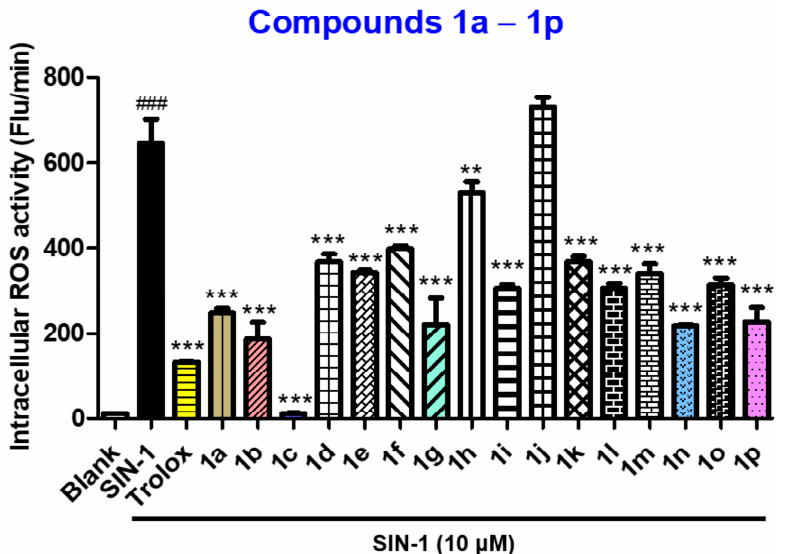
Figure 14. The intracellular ROS scavenging effects of compounds 1a – 1p . Intracellular ROS levels were evaluated using a DCFH-DA assay. The abilities of 1a – 1p to scavenge the oxidative stress induced by SIN-1 (10 µ M) were investigated at 20 µ M using B16F10 cells. Cells were pretreated with the compounds (20 μ M), and then exposed to 10 μ M SIN-1. The symbols * and # indicate significant differences between columns: ### p < 0.001 for cells treated with SIN-1 versus untreated groups; *** p < 0.001 and ** p < 0.01 for SIN-1-treated cells versus SIN-1 and compound- or trolox-treated cells.